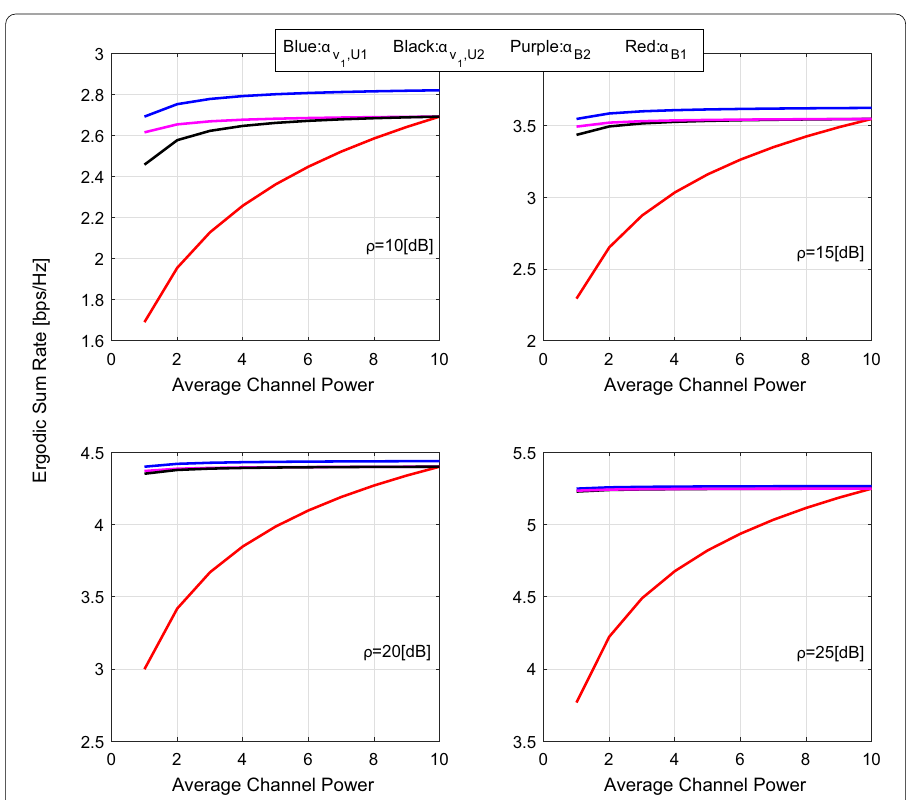
Fig. 3 The ergidic SR of overlap case for our proposed NOMA-IoV system versus the average channel power , α B for α v , α v and α B 1 , U 1 1 , U 2 1